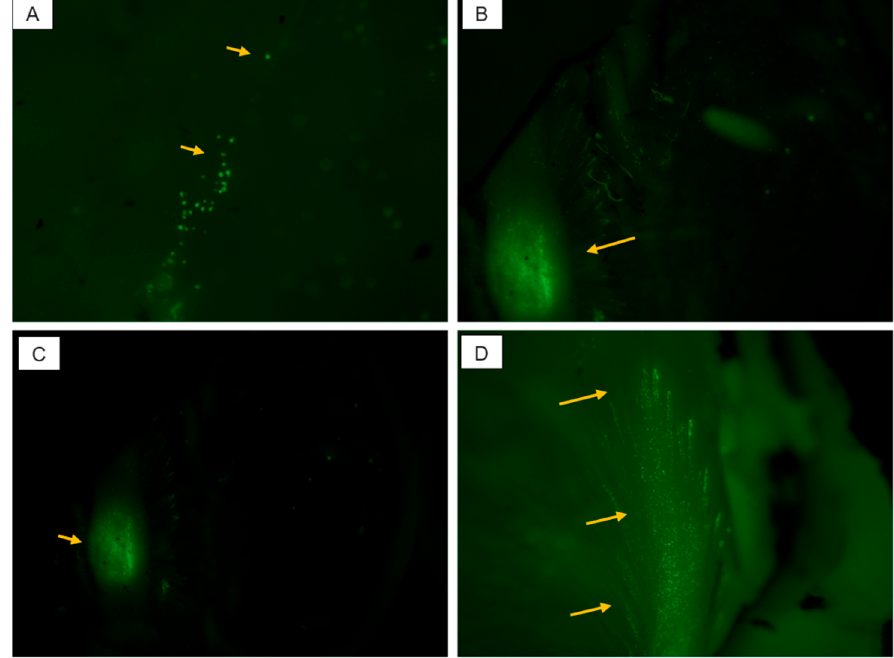
Figure 5. Micrographs (20×) of frozen rabbit vitreous ( A ), optic nerve polymersome accumulation ( B , C ) and polymersomes at retinal tissue layers ( D ). The arrows show localization of the polymersomes.